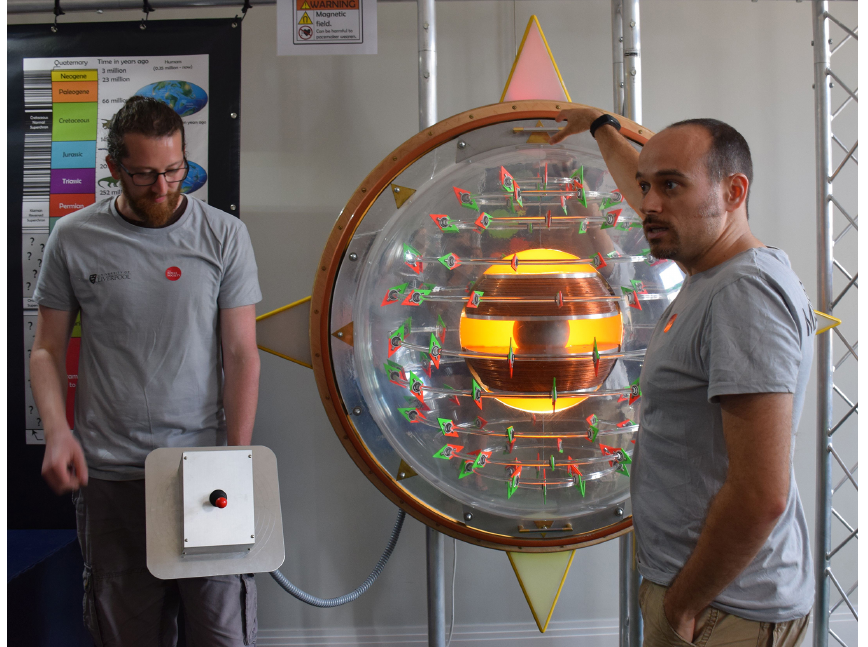
Figure 4. Daniele Thallner and Greig Paterson with the magnetic globe and switch.